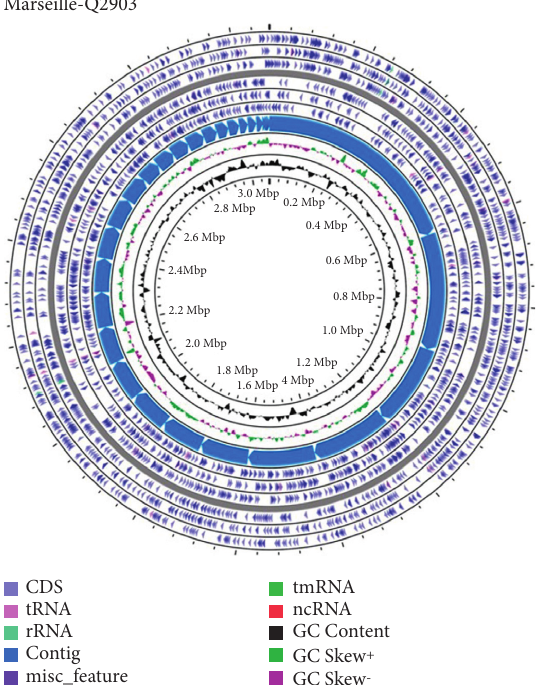
Figure 5: Graphical circular map of the genome of B . epidermidis strain Marseille-Q2903 T obtained by using the CGView